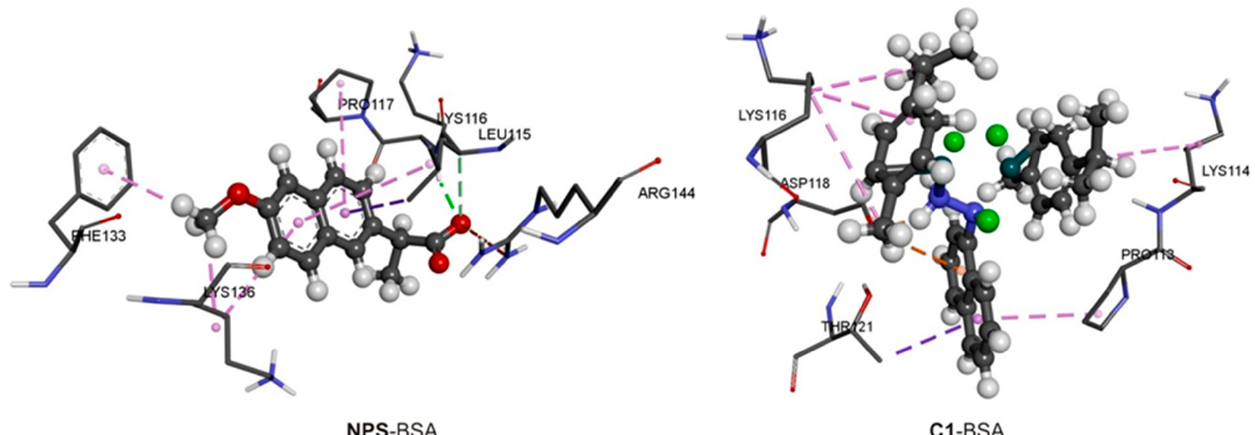
Table 3. Thermodynamic parameters of binding of 1 to BSA at different temperatures.